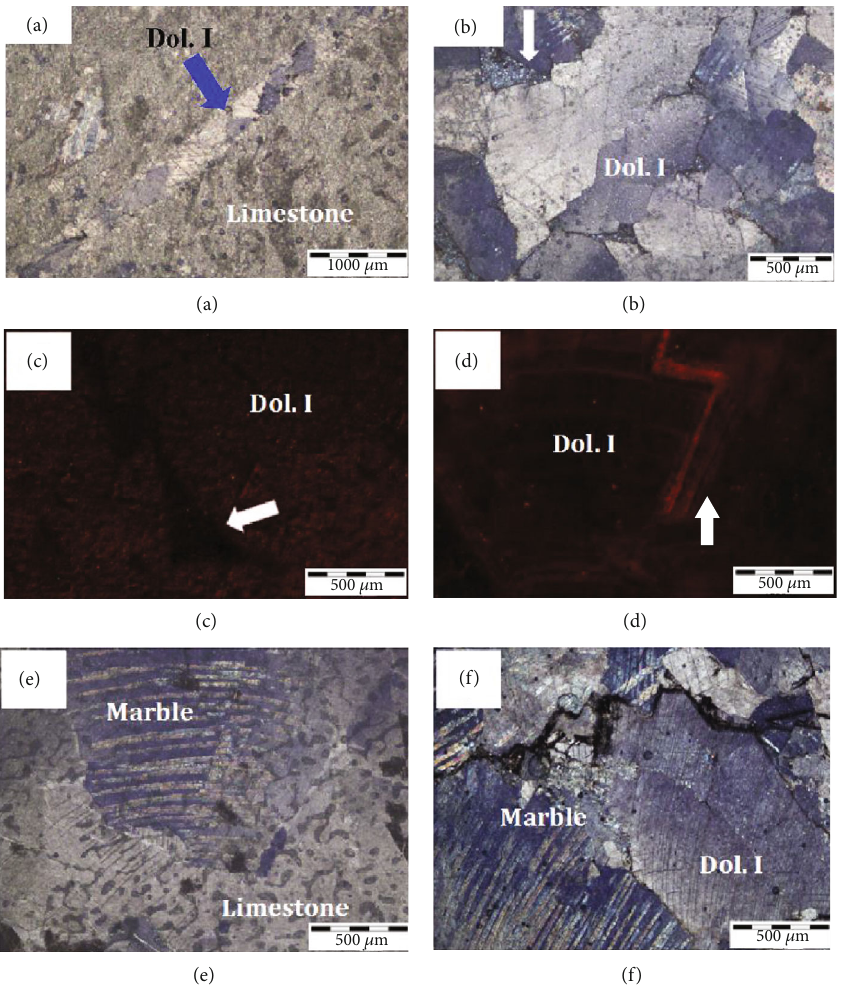
Figure 5: Petrographic studies of the Khyber Limestone showing various diagenetic phases. (a) Crossed-polarized photomicrograph of the coralline limestone (wacke- to packstone) containing fracture- fi lling dolomite (Dol. I) shown by blue arrow (b) Medium to coarse crystalline (Dol. I) exhibiting undulose extinction typical of saddle nature; clay minerals fi lling the intercrystalline pore spaces shown by white arrow. (c, d) Cathodoluminescence (CL) photomicrograph showing dull luminescent dolomite (Dol. I); pore- fi lling detrital clays are nonluminescent (arrow). (e) Partial replacement of coralline limestone with coarse-grained marble in the upper part while the limestone is in the lower part. (f) Partial to complete replacement of coarse crystalline, nonplanar dolomite by